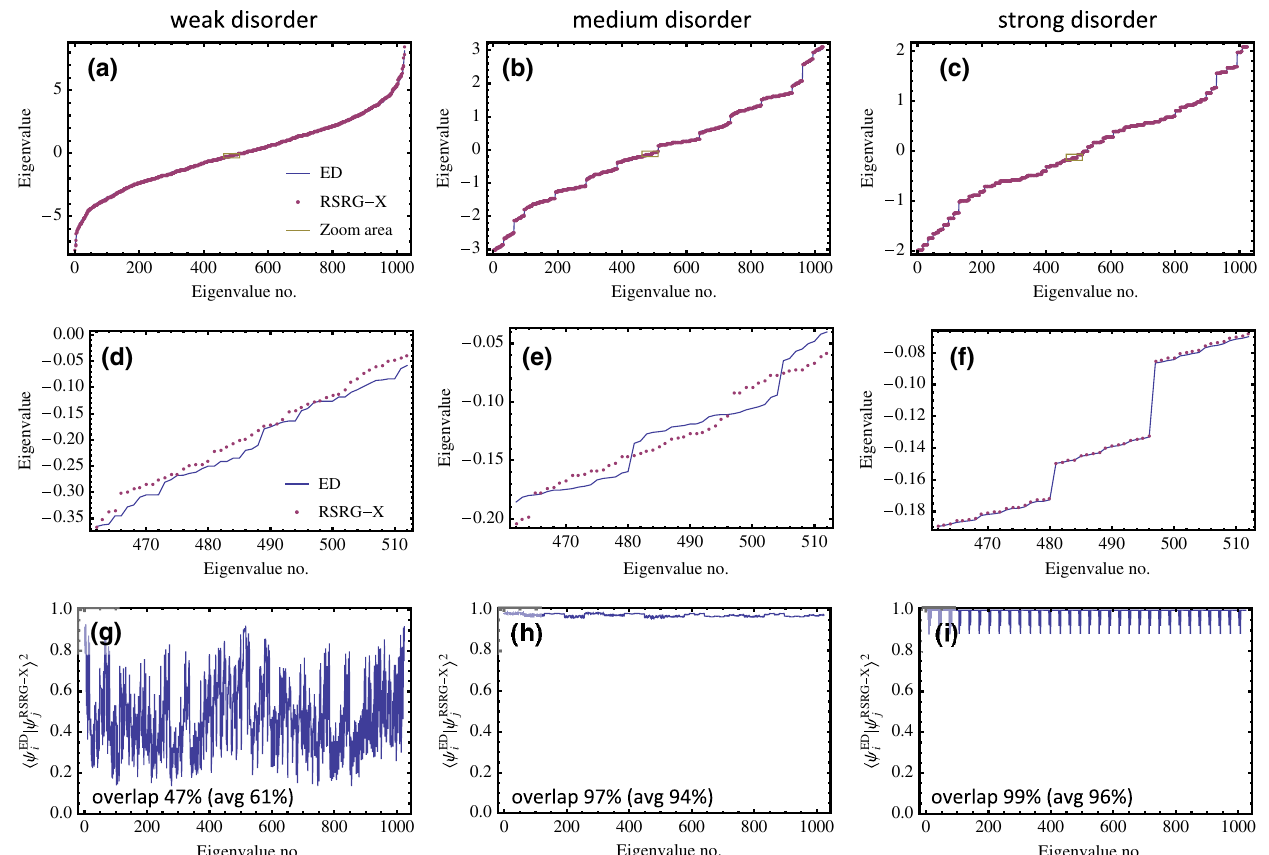
FIG. 6. (a) – (c) Comparison of the 1024 many-body eigenvalues computed using RSRG-X and ED for three representative 10-spin hJJ 0 chains with weak, medium, and strong disorder. (d) – (f) Zoom in on spectra shown in (a) – (c). (g) – (i) Overlap of RSRG-X and ED eigenfunctions. The average overlap for the given disorder realization is indicated in the bottom of the figure (the disorder averaged overlap, frrm Fig. 7, is indicated in brackets). (See text for